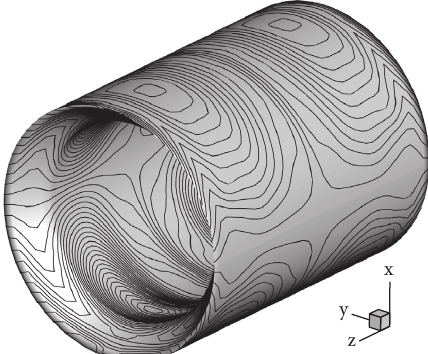
Figure 5: Winding patterns of the designed cylindrical transverse gradient coil with displacement optimization. The transport cur- rent is 439.1 A for the target gradient strength of 30mT/m, and the minimum wire gap is 3.9 mm.